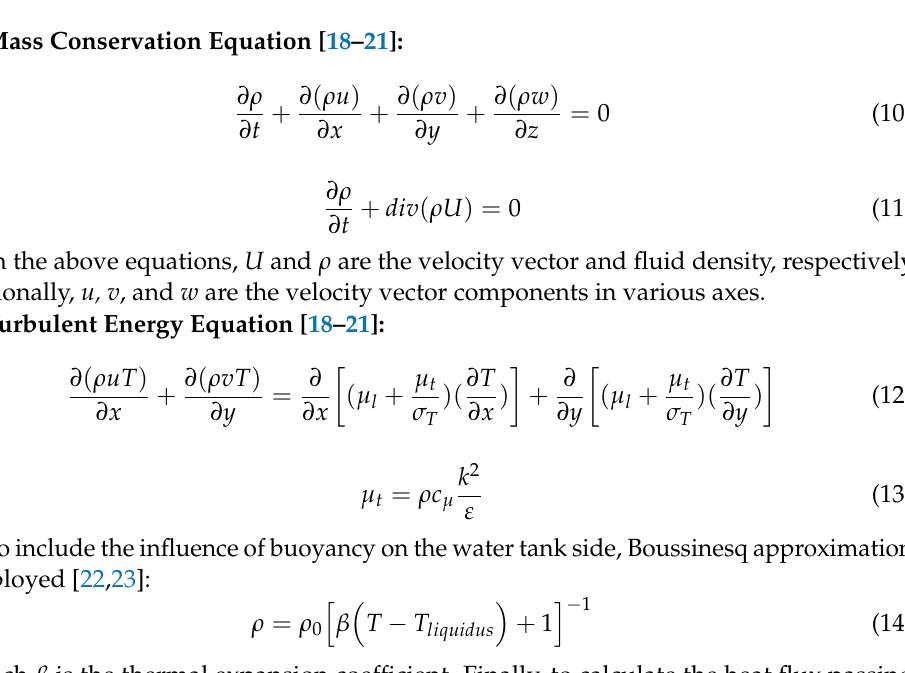
Figure 2. Contour of y+ distribution on the surface of the tube.